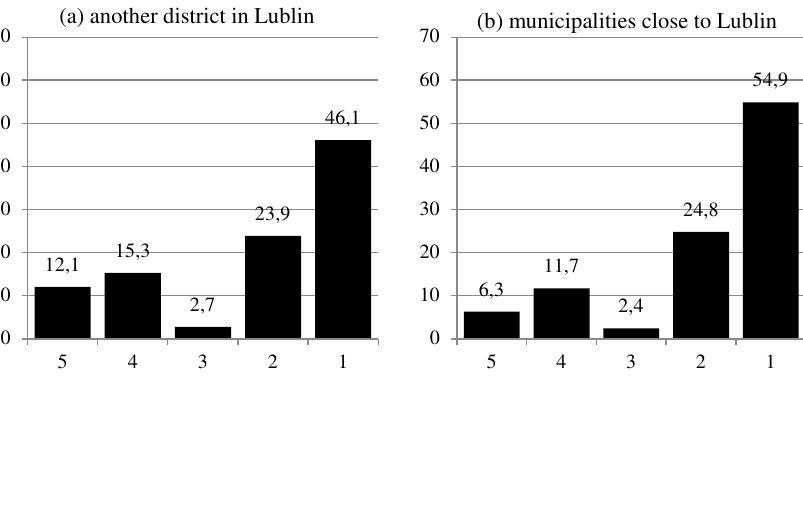
Figure 1. Distribution of the intention to move among the respondents (in